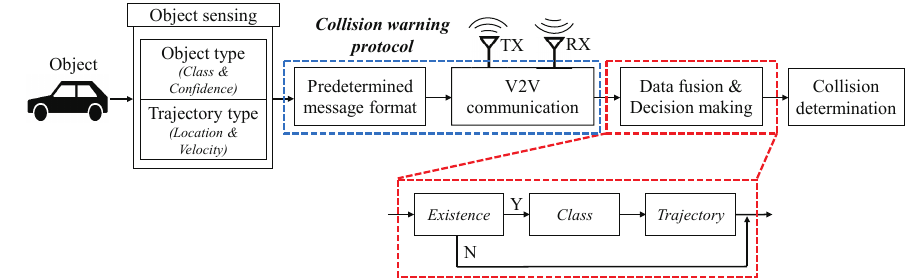
Figure 5. Proposed collision warning